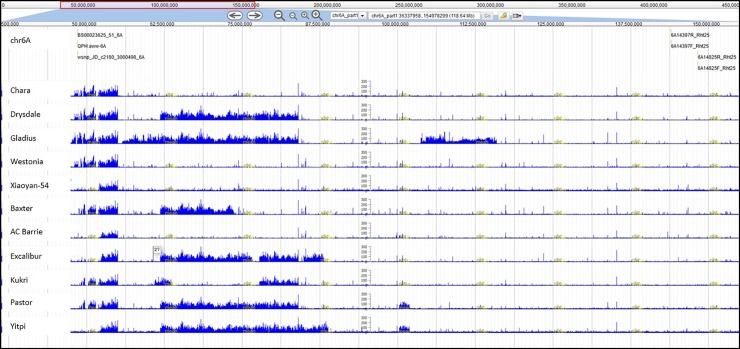
DAWN screenshot of chromosome 6A region containing QPh.aww-6A and Rht-25 loci on Chinese Spring RefSeq v1.0.The “Genes” track shows the high confidence genes according to the RefSeq annotation v 1.0. The blue tracks show the variant density (SNP per 10 Kb–log scaled) in comparison to RefSeq v1.0 for 11 wheat accessions; the different profiles across this region indicates that QPh.aww-6A and Rht-25 segregate independently.